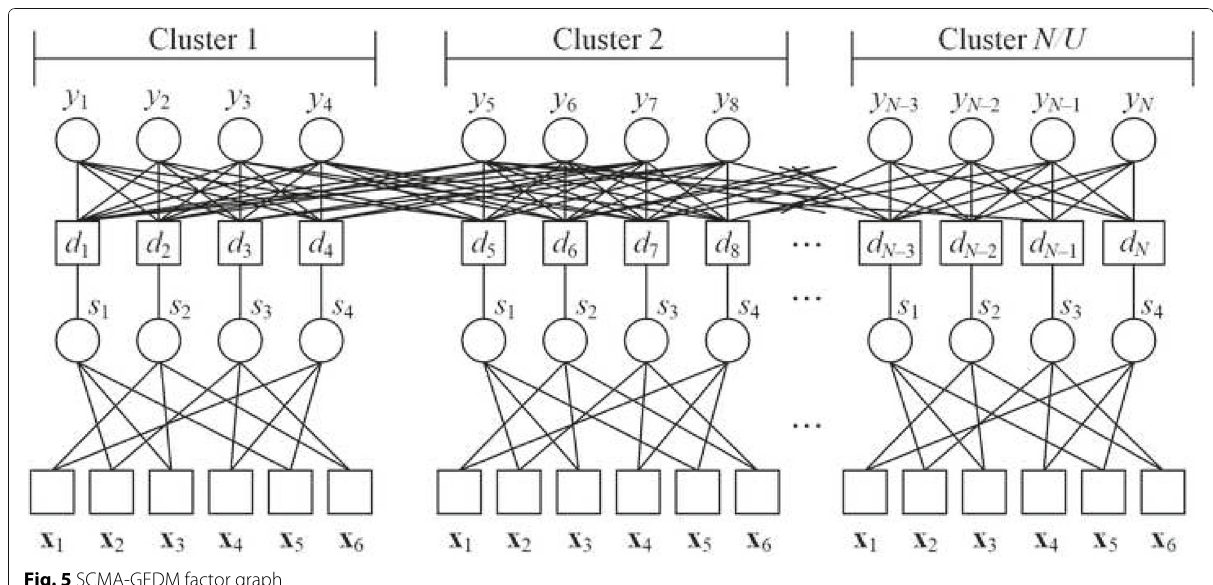
Fig. 5 SCMA-GFDM factor graph